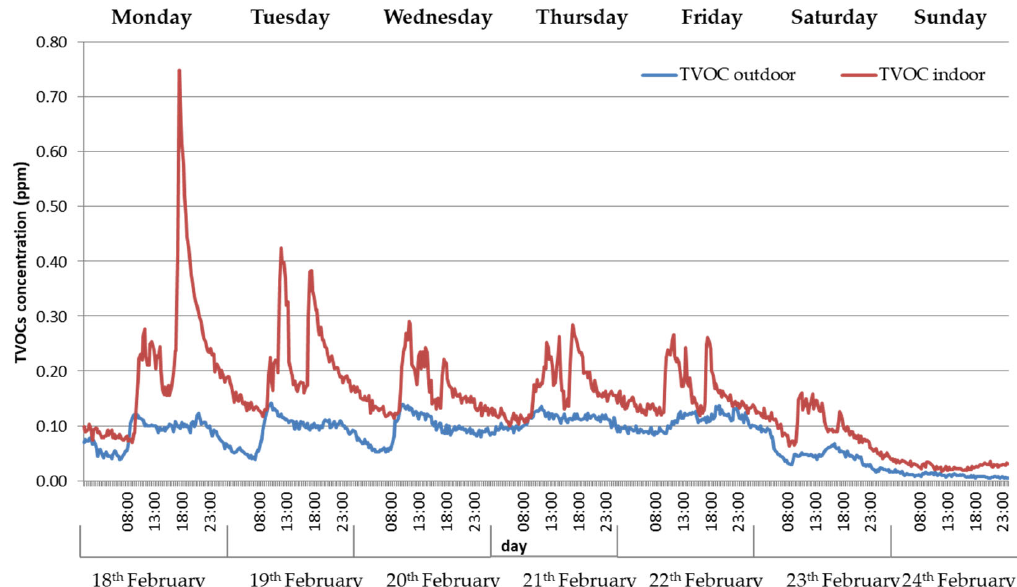
Figure 2. Indoor and outdoor TVOCs concentration profiles over the period 18–24 February (classroom 4E and its balcony, respectively). Table 2. Indoor average concentration and reference values for main VOCs investigated.